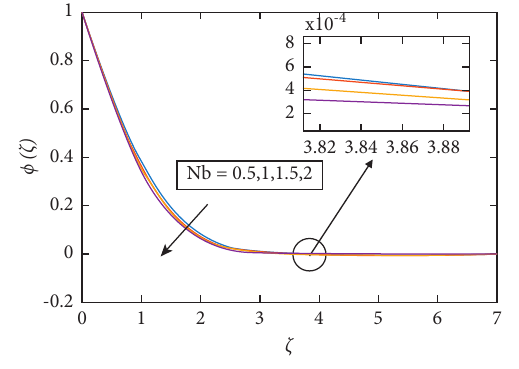
Figure 21: δ variation on φ ( ζ )